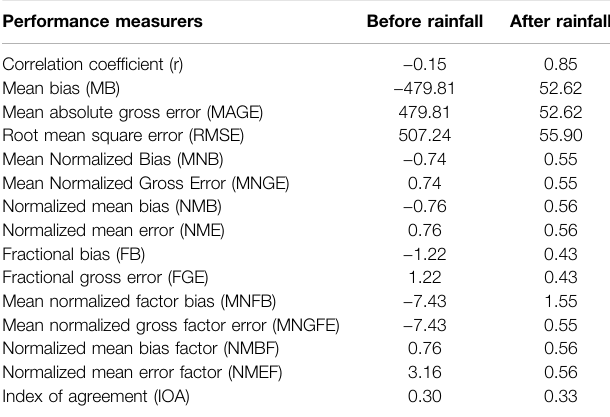
TABLE 3 | Performance of the GFLSM for estimating particulate concentration before and after rainfall. Performance measurers Before rainfall After